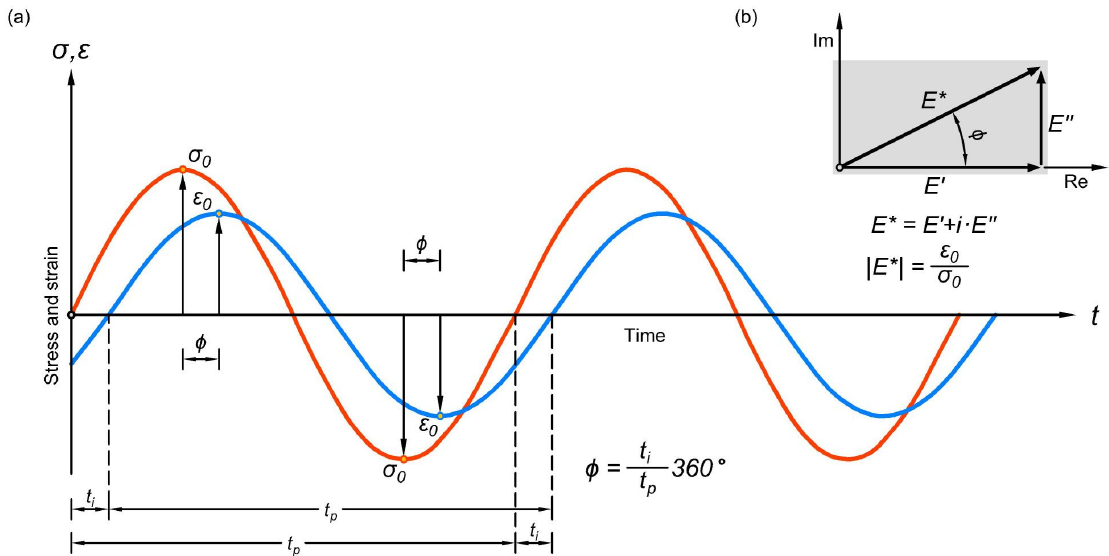
Figure 1. Response of the asphalt material to an excitation by a zero middle value clear sinusoidal pulse ( a ); the complex modulus and its components on the complex plane ( b ).